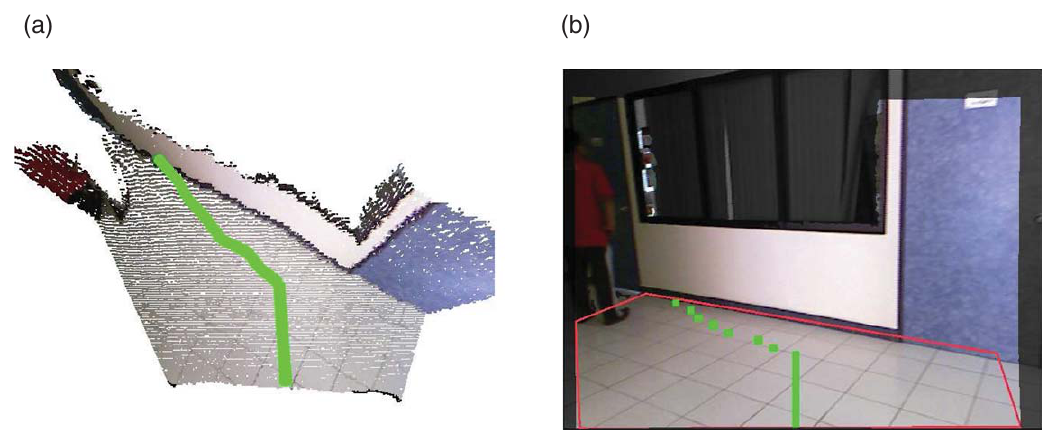
Fig. 7. (a) (left) 3D structure: the floor is identified and the path is computed; (b) (right) path at the polygon of free space avoiding a person.